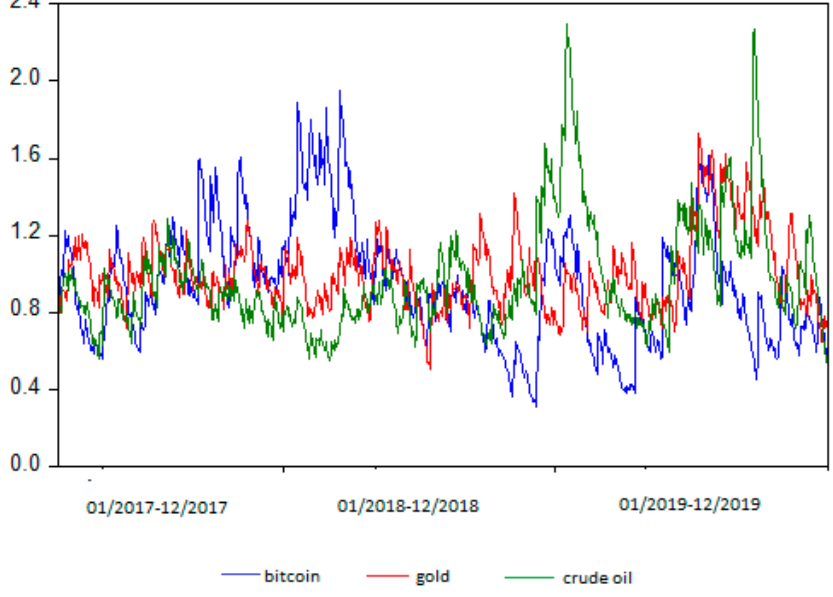
Figure 2. Daily volatility series for bitcoin, gold, and crude oil. Table 2. Descriptive statistics for the daily volatility